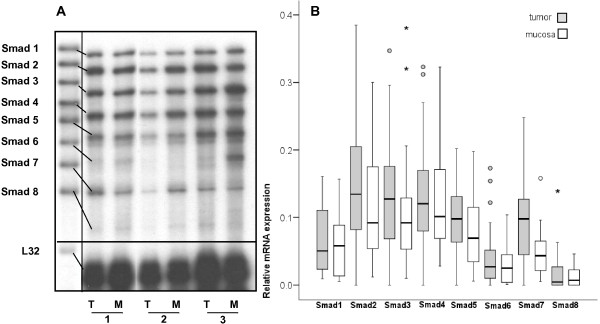
Smad mRNA expression in oral SCC: A. RPA representative assay. Lane 1: riboprobe; represented as pairs: T-tumor M- matched adjacent mucosa; L32: housekeeping gene. B. Boxplot representing Smad1-8 mRNA expression. Boxes: 25th, 50th and 75th percentiles; bars: 10th and 90th percentiles; °: outlier values (1.5-3 box-lengths from 75th percentiles); *: extreme values (>3 box-lengths from 75th percentiles).